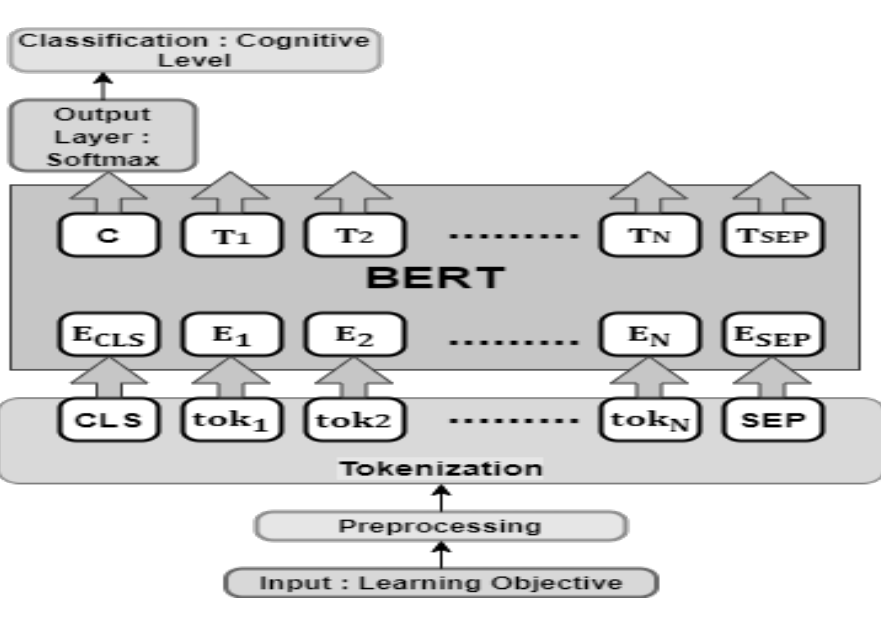
BERT-Based Fine-Tuning